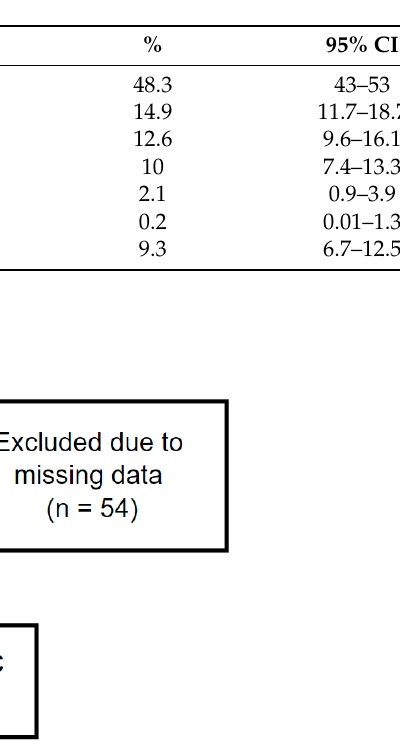
Figure 1. Flowchart of the study analysis according to STROBE guidelines.